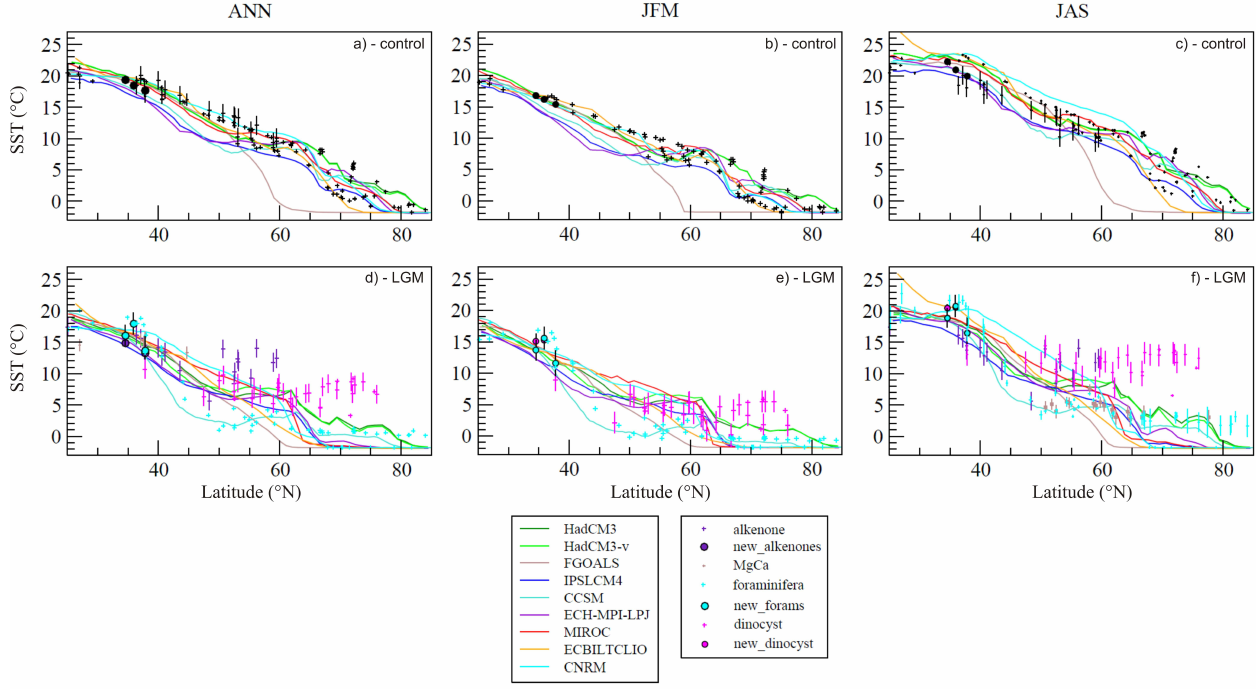
Fig. 9. Comparison, for the present and Last Glacial Maximum (LGM) periods, between the new reconstructions from this study, the previous reconstructions from the MARGO project (http://margo.pangaea.de/) and PMIP2 model results. Top panels (a) , (b) and (c) : Pre-industrial states (control) for the Annual (ANN), winter (JFM) and summer (JJA) means. Bottom panels (d) , (e) and (f) : LGM states. The lines are the longitudinal averages of simulated sea surface temperatures in a sector covering 35 ◦ W to 20 ◦ E in the North Atlantic, for a latitudinal transect 25 to 85 ◦ N. Symbols represent SST reconstructions, with the new ones (this study) represented by large circles. Model name abbreviations: HadCM3-v: HadCM3 coupled atmosphere-ocean-vegetation run. ECH-MPI-LPJ is for the ECHAM53-MPIOM127-LPJ and MIROC is for